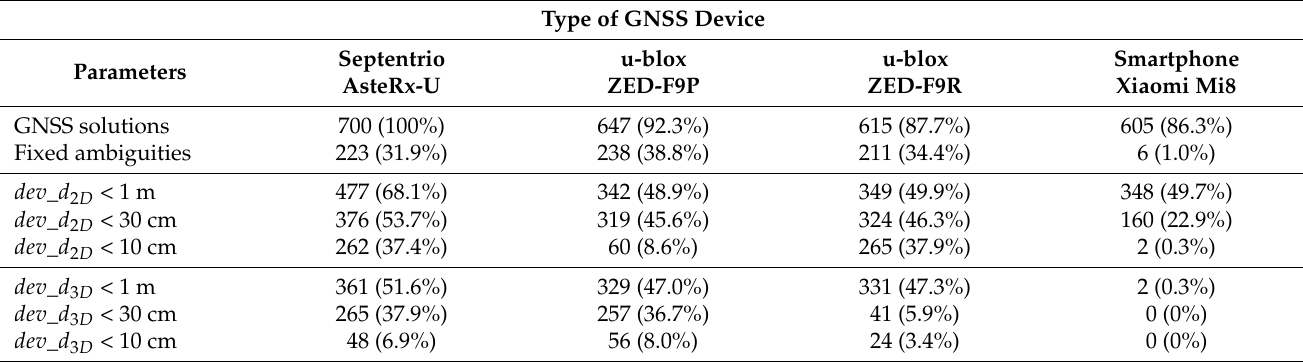
Table 10. GNSS solutions, solutions with fixed ambiguities, and deviation of distances below the given threshold. Situation: Case B—urban area (no. of total solutions: